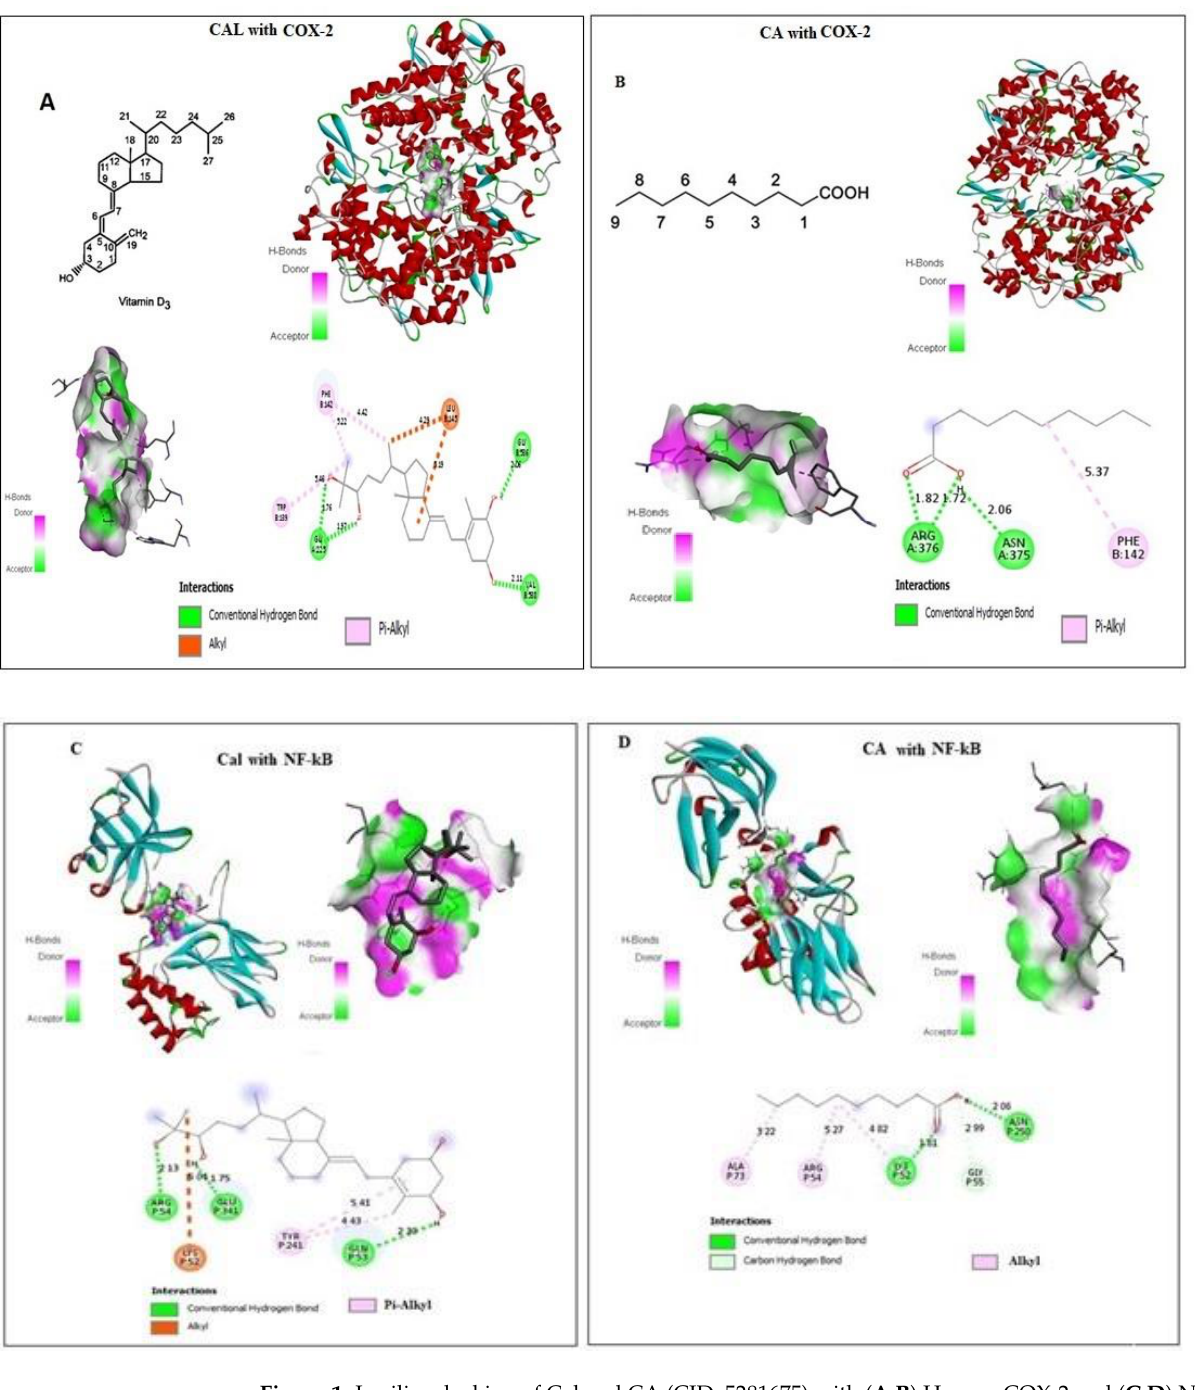
Figure 1. In silico docking of Calcitriol and capric acid (CID: 5281675) with (A, B) Human NF- κB and (C, D) COX-2 proteins binding analysis. Computational binding was executed applying WhatIF server, Pymol and AutoDock tools to determine the interactions with NF- κB and COX-2 binding pocket, showing the interacted amino acid residues and bond length.